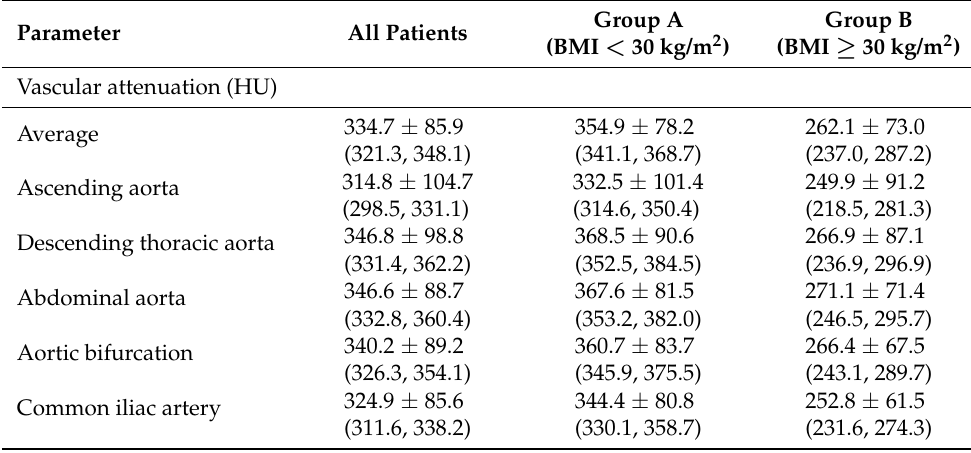
Table 3. Objective image quality of the low-dose CTA